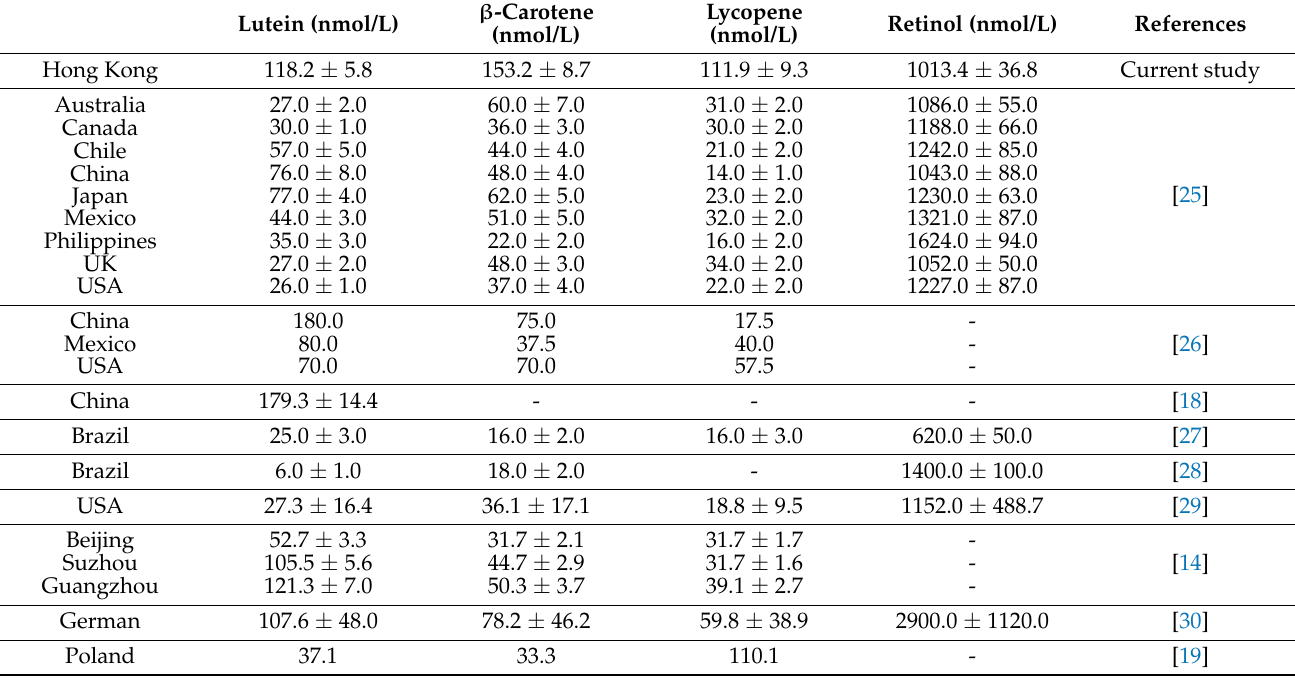
Table 5. Comparison of carotenoid and retinol levels in breastmilk with other populations. β -Carotene Lycopene Lutein (nmol/L) Retinol (nmol/L) (nmol/L)